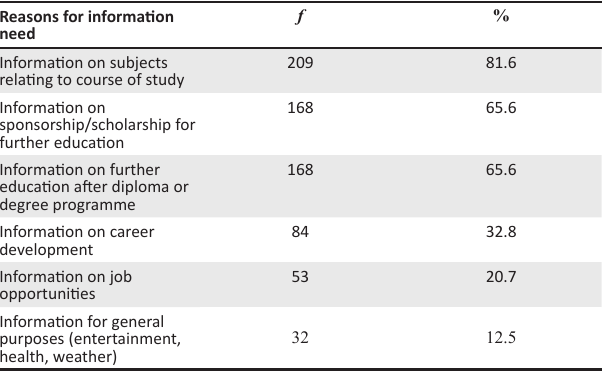
TABLE 1: Information needs of the ODL students at MZUNI ( n = 258).